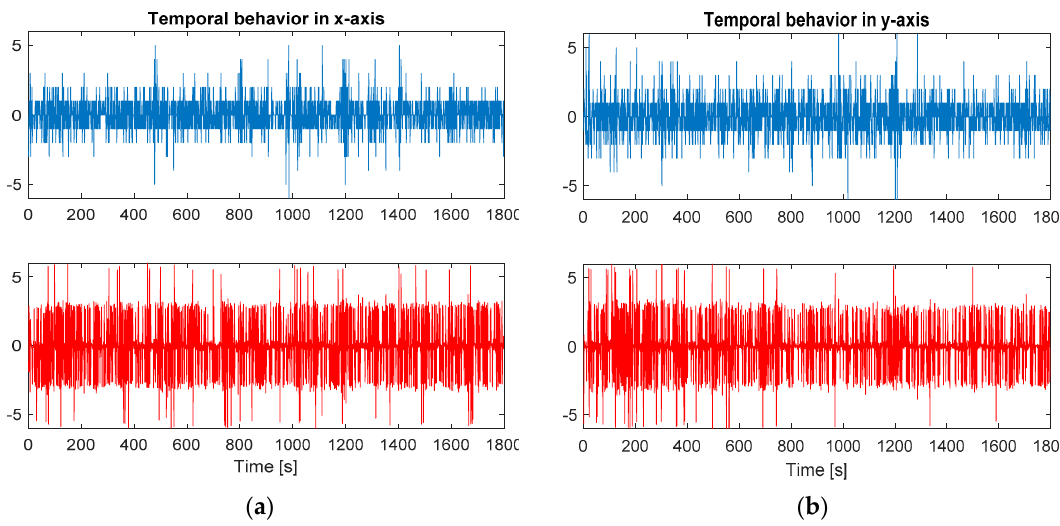
Figure 7. Temporal distribution, in cartesian coordinates, of centroid fluctuations to Pattern Test. Up: Measured at distance z 3 , Down: estimated at distance z 3 from distance z 1 and z 2 . ( a ) X-axis. ( b ) Y-axis. Source: Authors.